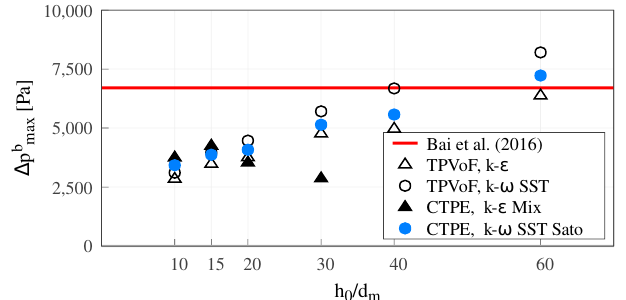
Figure 8. Maximum pressure increment at the spillway bottom. The location of the maximum pressure increment L m is the distance along the chute bot- tom from the offset step to a point where the pressure increment is maximum ( ∆ p b = ∆ p b max ), see Figure 9.